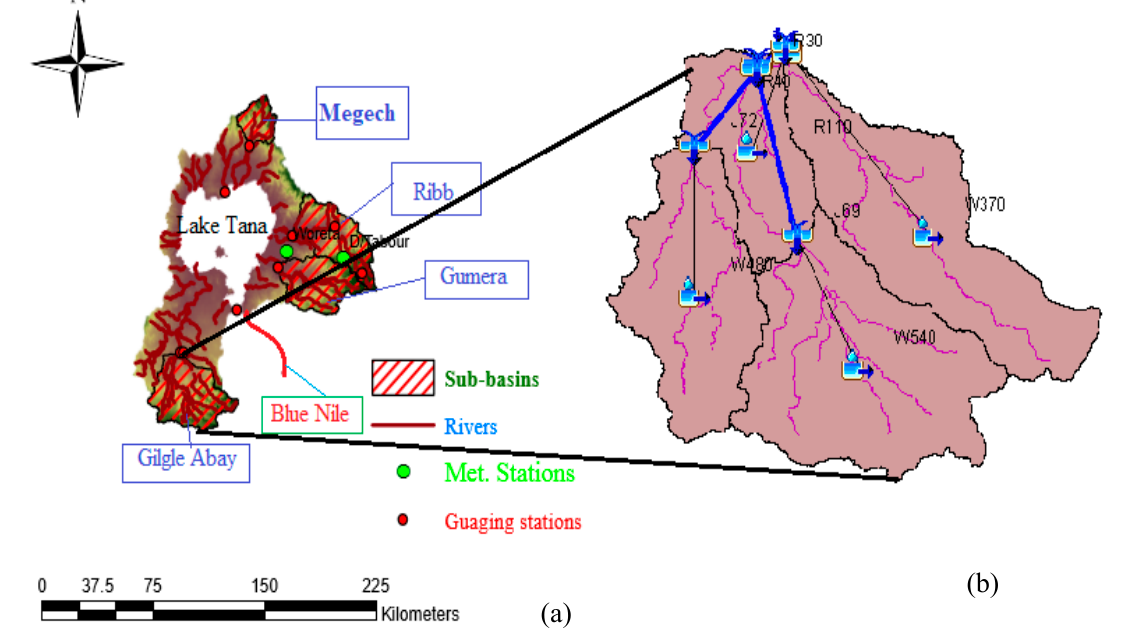
Figure 1. Location of ( a ) Lake Tana Basin with hydro-meteorological stations and ( b ) Basin Model of Gilgel Abay Catchment.